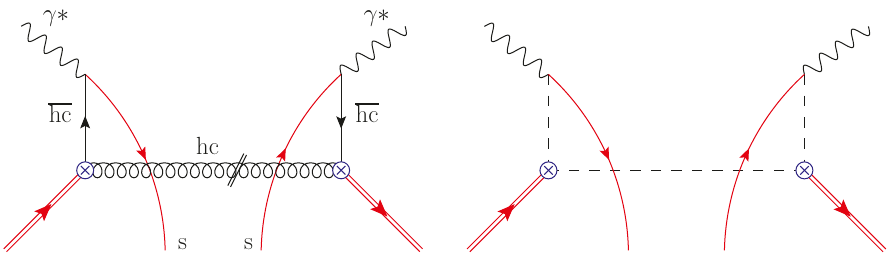
contribution onto SCET O 8 g (cid:0) O 8 g